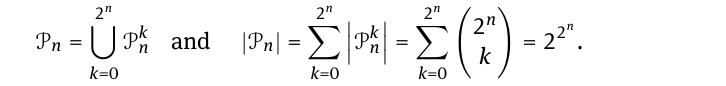
Such a map can be seen as a two-coloring of the vertices of I n with “colors” 0 and 1. We denote the set of all maps B n → { 0, 1 } by P